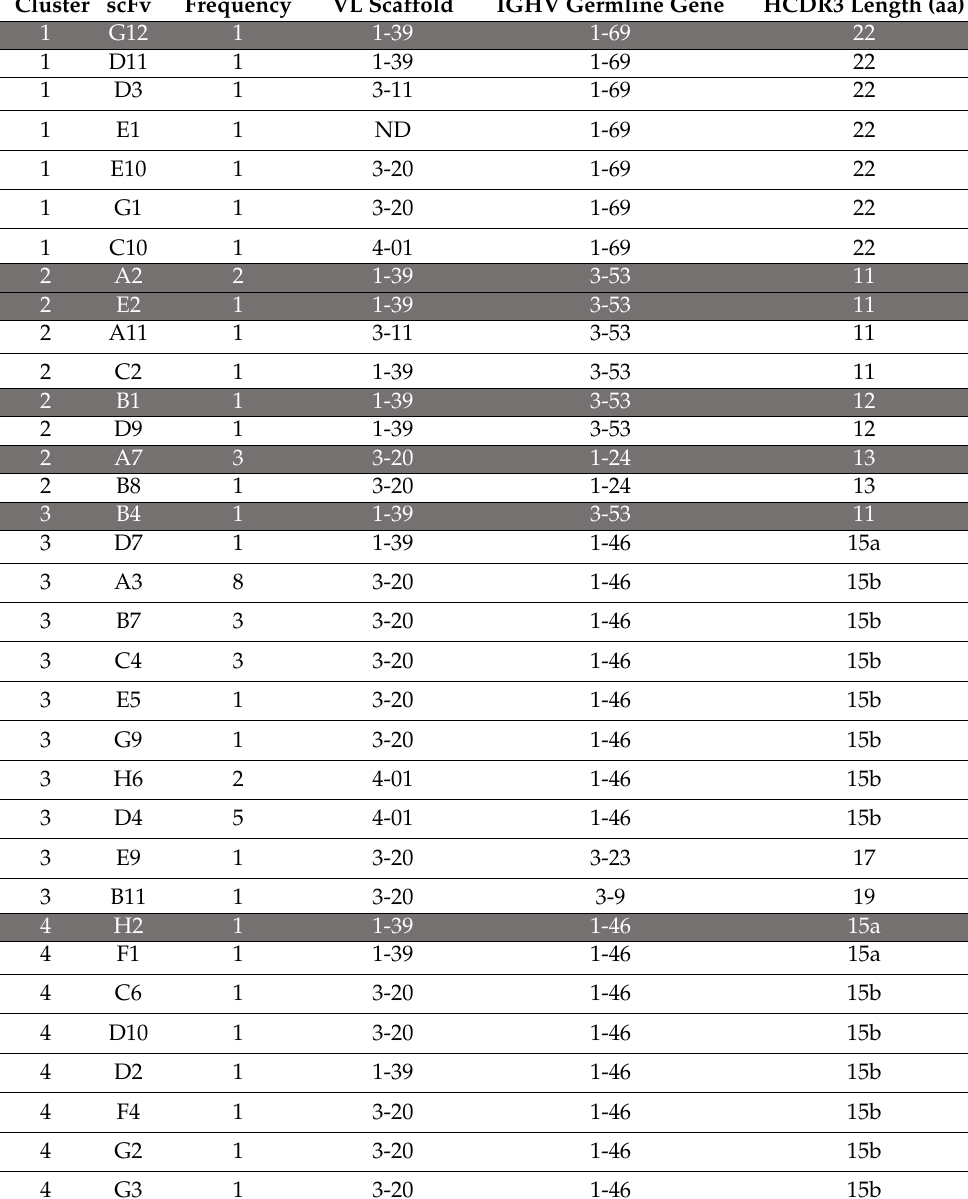
Table 1. Sequence features of the 34 unique scFvs shown in Figure 1. “Frequency” means the number of times a given sequence was found in the 53 positive clones. “VL” is the synthetic scaffold of the scFvs. “IGHV” is the germline gene determined by comparison with the human IGHV germline gene repertoire using IgBLAST (https://www.ncbi.nlm.nih.gov/igblast/; accessed on 5 January, 2022). “HCDR3 length” lists the number of amino acids per HCDR3 in that region (Kabat’s definition). Notice that, in C3 and C4, two different HCDR3 of 15 residues are reported, which are distinguished from each other with “15a” and “15b”. Highlighted in grey are the scFvs progressed to hIgG1 conversion. Cluster scFv VL Scaffold IGHV Germline